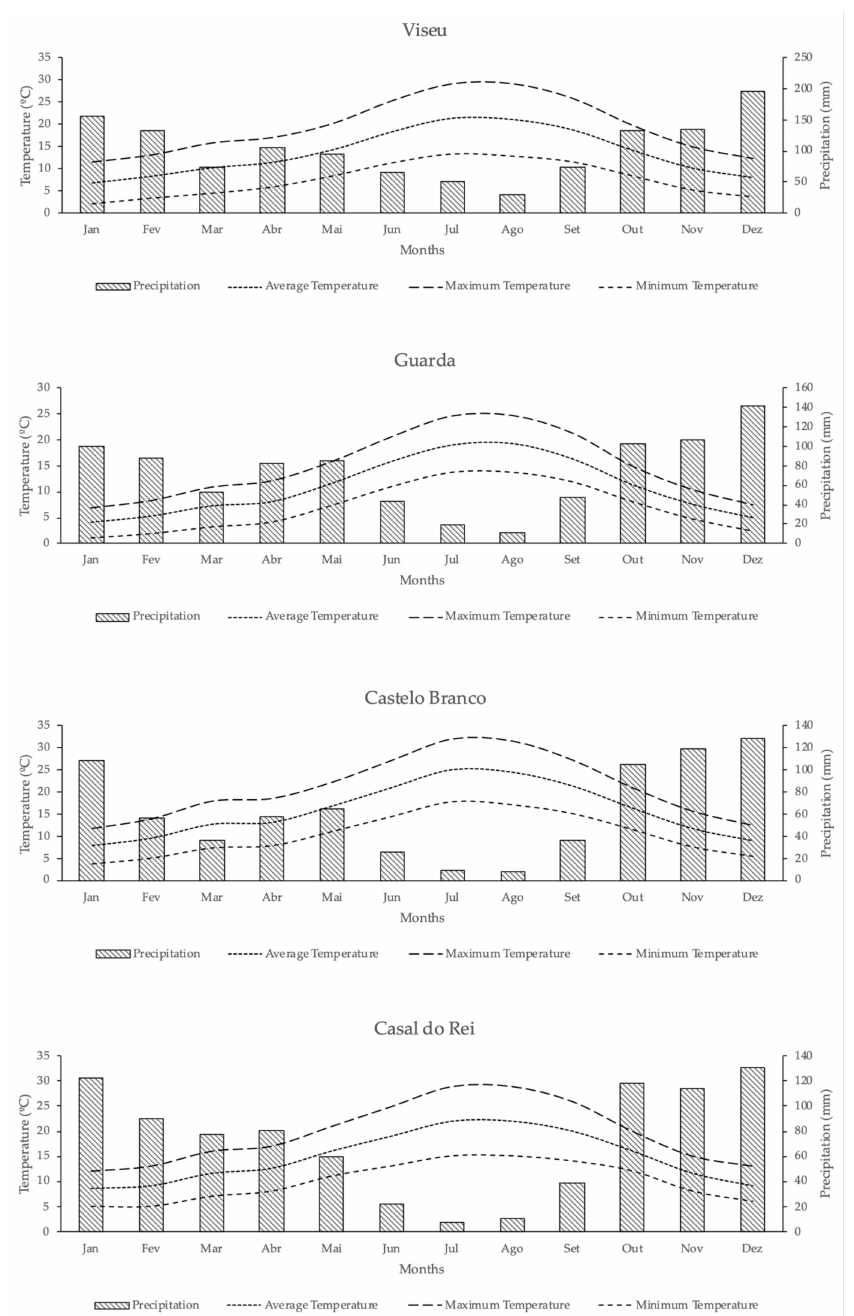
Figure 5. Data that were collected for the three selected stations, Viseu, Guarda and Castelo Branco, and the data modelled for Casal do